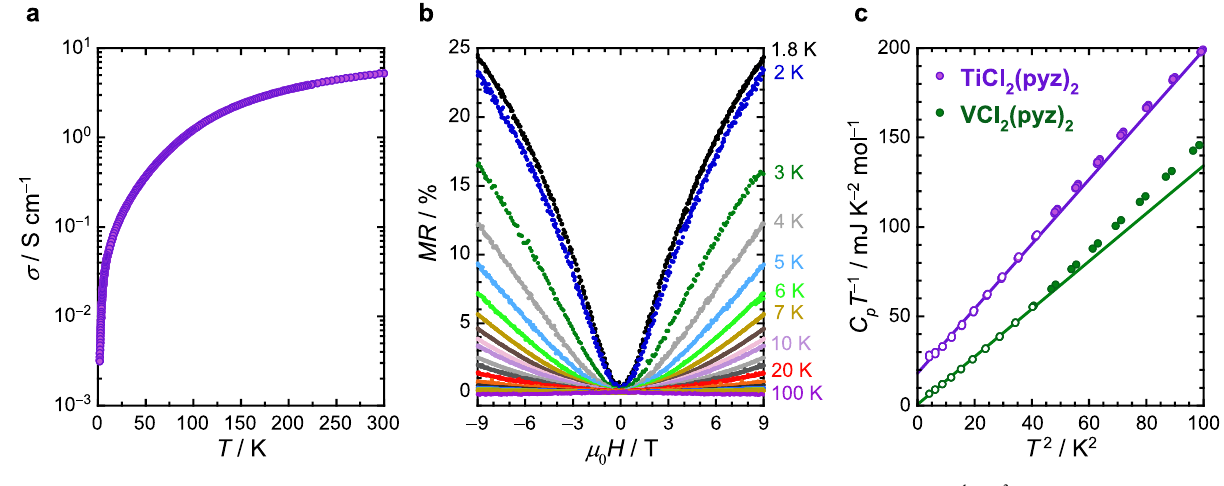
c Speci fi c heat capacity, C p , shown as C p T – 1 vs T 2 (all symbols) for TiCl 2 (pyz) 2 (purple) and VCl 2 (pyz) 2 (green). Solidlinesarebest fi ts to the data (shown inopen circles) as described in the